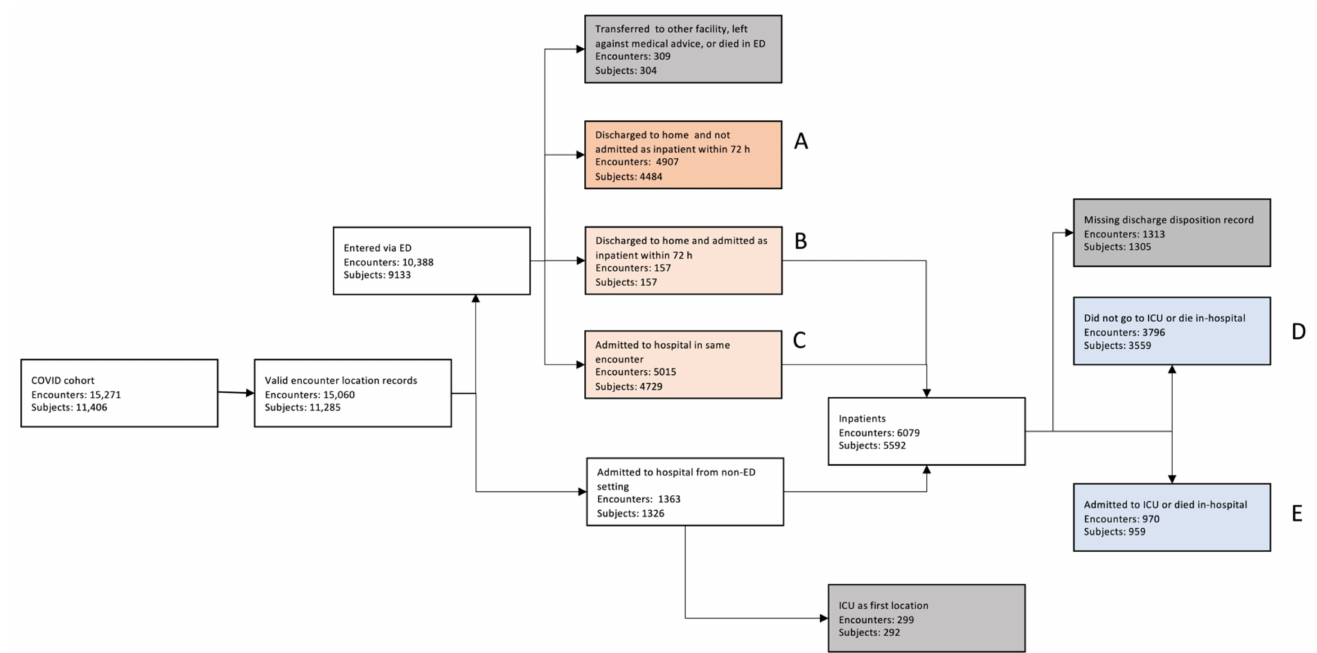
Figure 2. CONSORT diagram for patients included in the